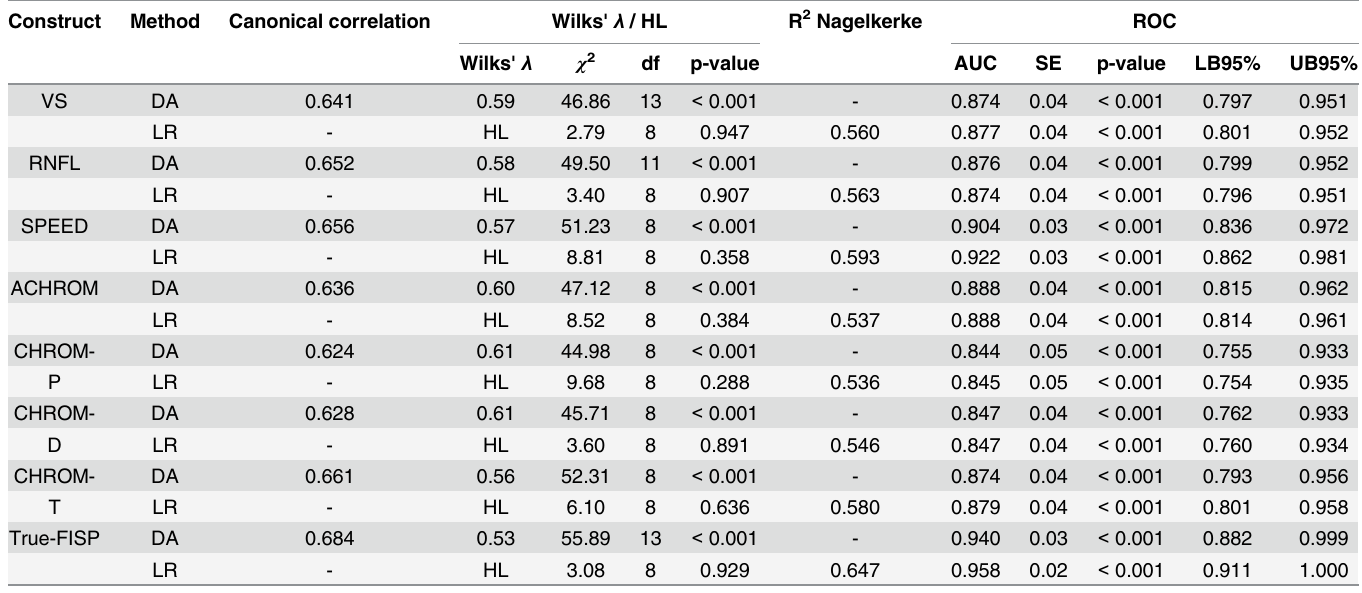
Table 3. Validation summary for constructs derived from original